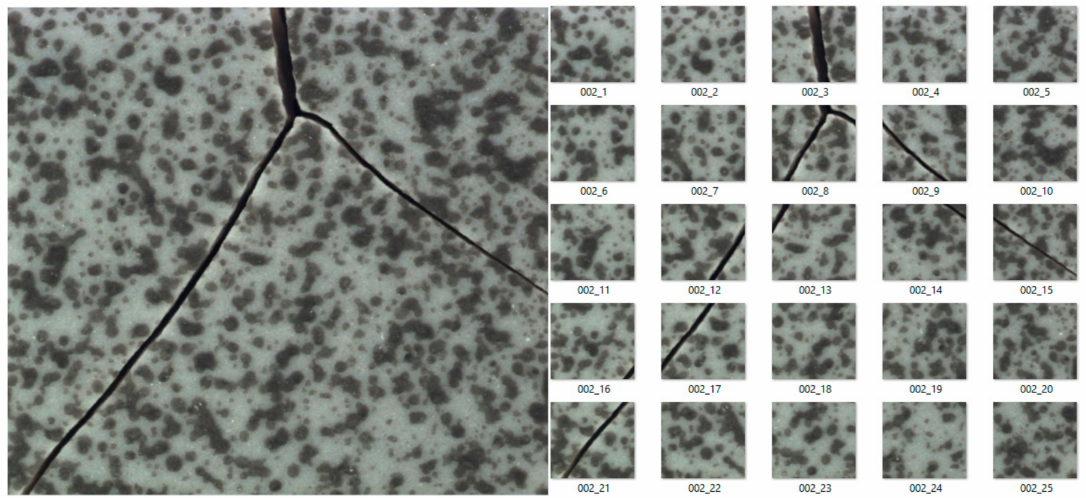
Figure 5. Subdivision of images for the tile